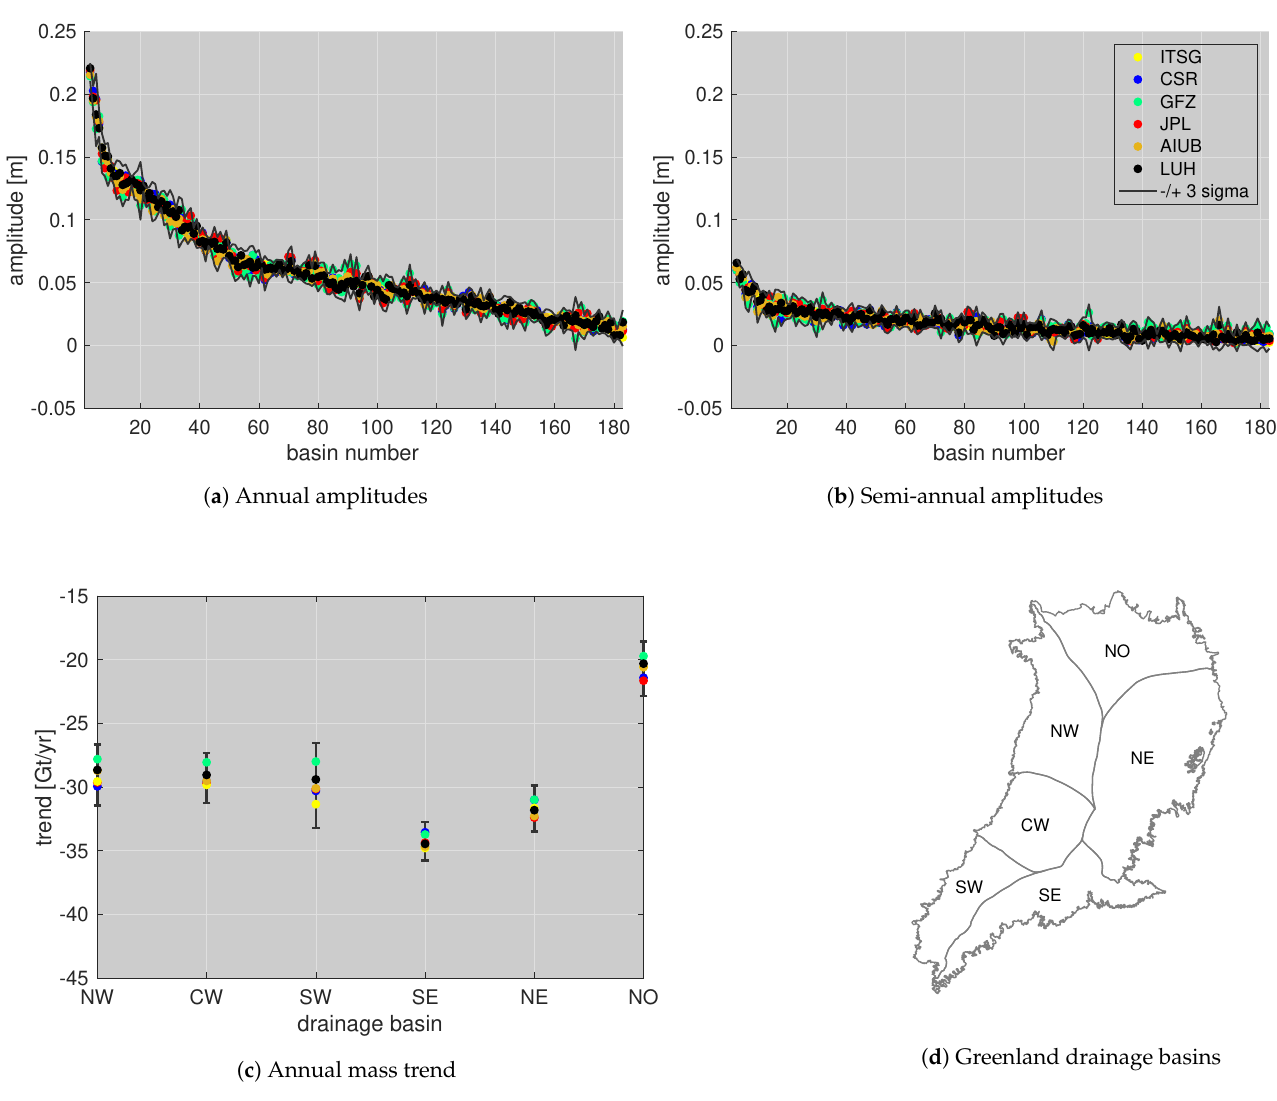
Figure 3. Upper panels: Annual ( a ) and semi-annual ( b ) river basin amplitudes in terms of mean EWH. 3-sigma-limits are with regard to the mean amplitudes of all ACs. The river basin numbers in ( a , b ) do not correspond to each other. Bottom panels: Annual mass change trend ( c ) in six regions of Greenland ( d ). C 20 and C 30 are replaced with SLR values. Gaussian filter with a 400 km averaging radius applied. Presented results are based on data from June 2018 until December